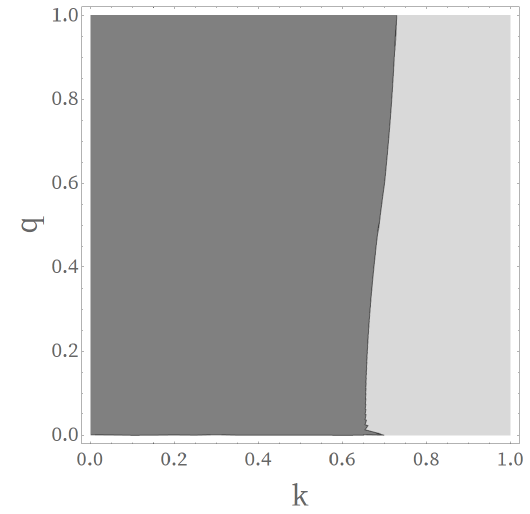
Figure 5. Instability diagram for Bloch waves with k ∈ [0 , 1] and q ∈ [0 , 1] . In the darker grey region (the left part in the figure), Im( ω M ) ≤ 0 , and in the lighter grey region (the right part in the figure), Im( ω M ) > 0 .